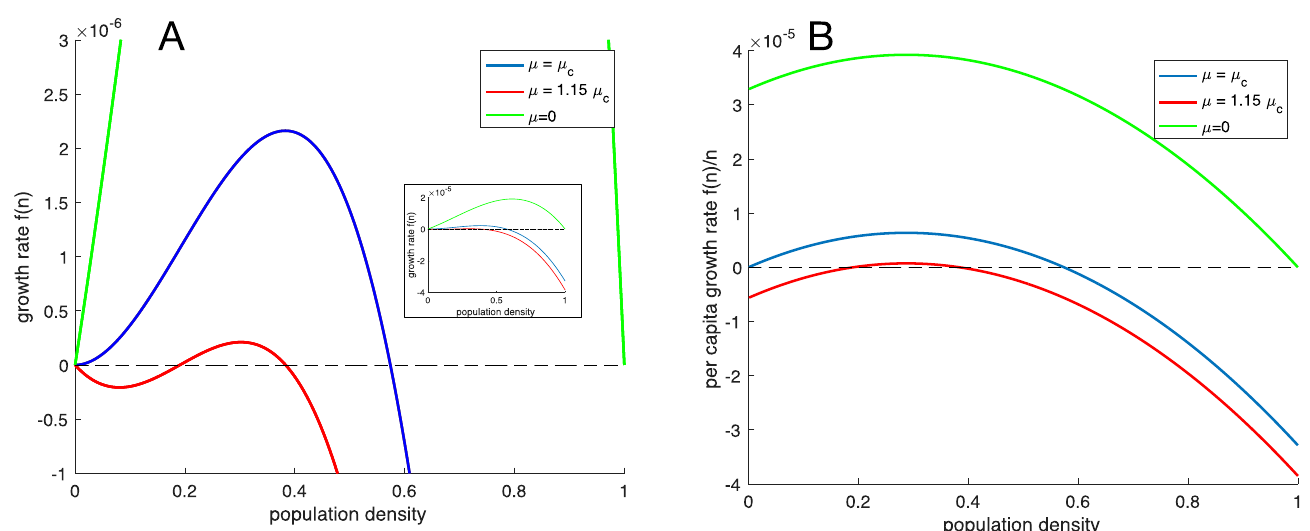
Fig 2. Growth rates. (A) The population growth rate (3) as a function of the population density for three different values of the death rate μ . The inset shows the entire range of growth rates. (B) The per-capita growth rate f ( n )/ n as a function of the population density for three different values of the death rate μ . Here the Allee effect is evident as an increasing per-capita growth rate at low densities. All parameter values are given in Table 1 and the critical death rate is calculated according to